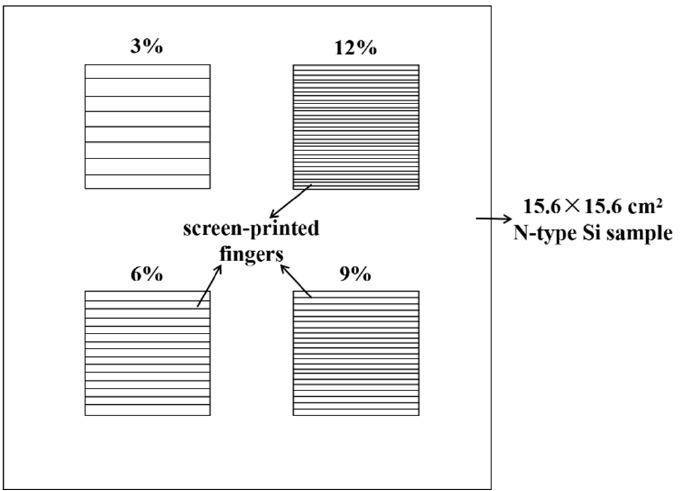
Figure 3. The screen-printing pattern of the sample with different metallization fraction from 3% to 12%. 3% to